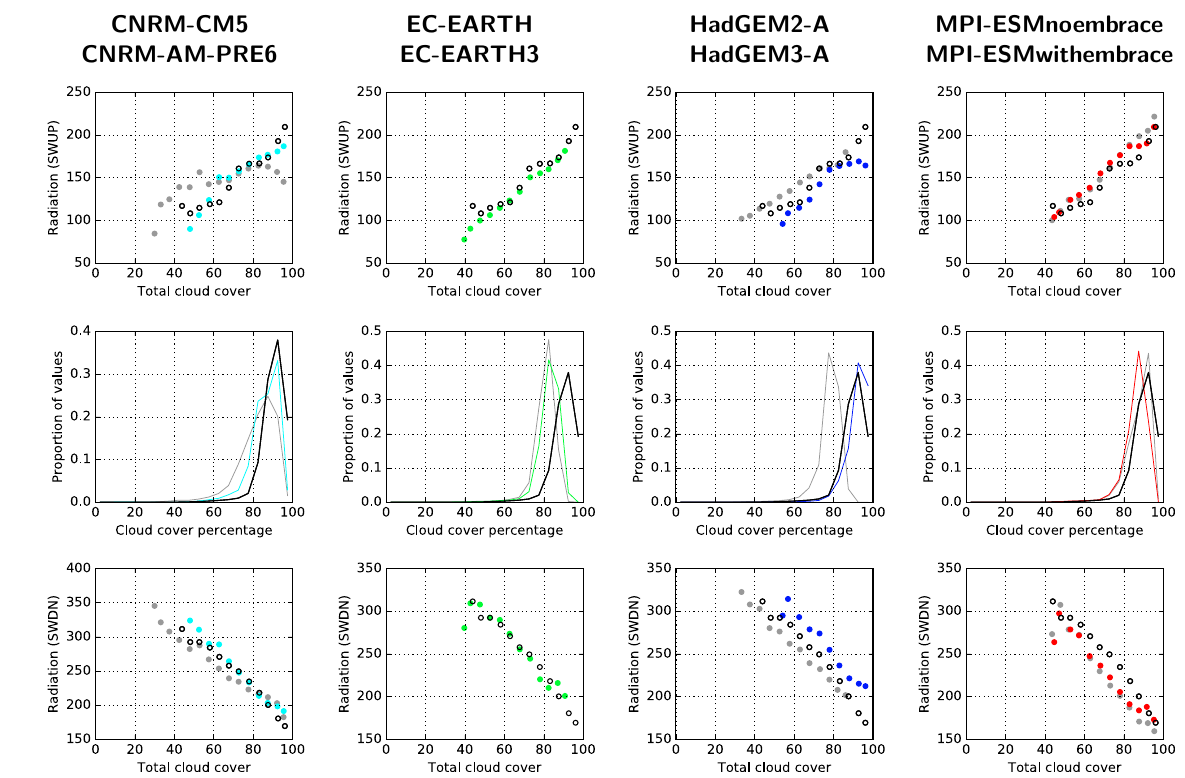
Figure 19. As Fig. 17 but for the southern part of the Southern Ocean region (SOC-S, 50–65 ◦